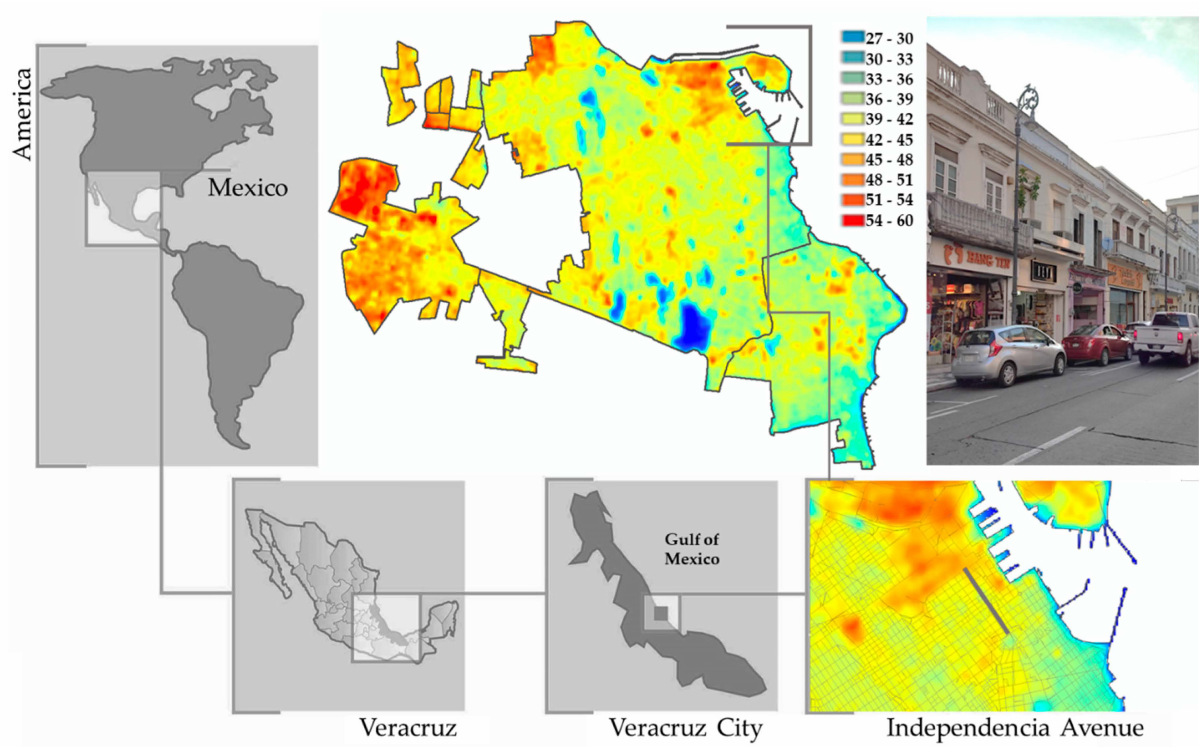
Figure 1. Location of the case study, map of isotherms (values in ◦ C) of the superficial urban heat island of the metropolitan area of Veracruz and Boca del Rio on 4 May 2017, and photograph of the